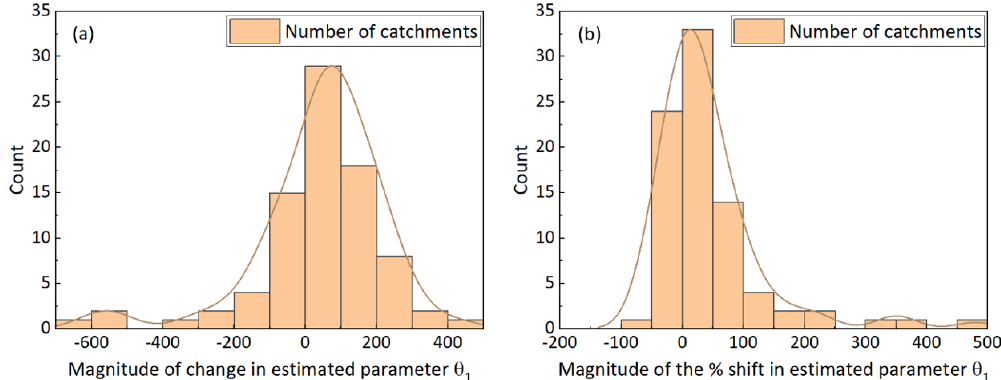
Figure 5. Shift magnitudes of the CWSC between the periods before and after the change point. The orange lines denote the kernel smoother curve of the